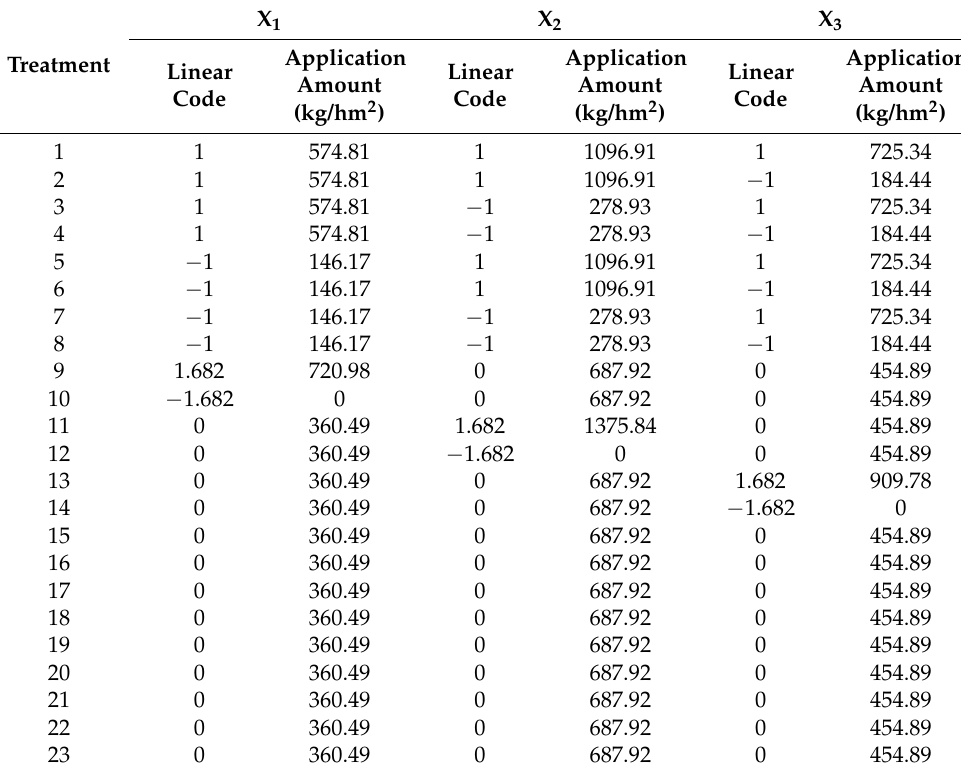
Table 3. Trial structure matrix and different treatments in the experiment.